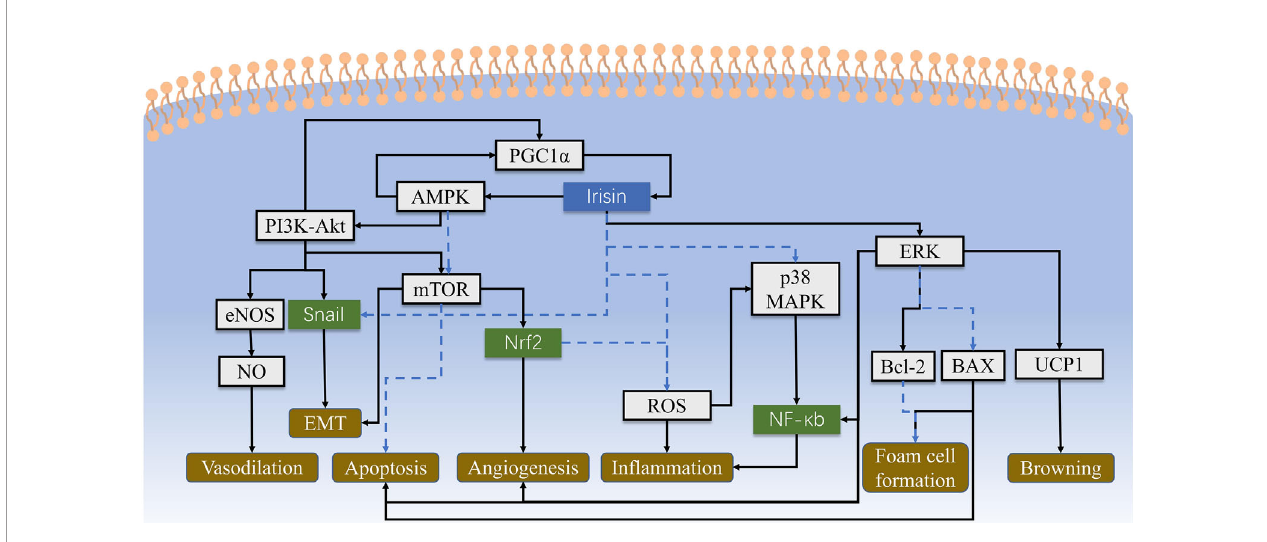
FIGURE 2 | The cell signaling pathways of irisin are intricate and haven ’ t been fully identi fi ed yet. This fi gure shows main cellular biological processes concerning atherosclerosis and CHD, which include AMPK-PI3K-Akt-eNOS, AKT/mTOR, p38 MAPK and ERK pathways to regulate in fl ammation, angiogenesis and other physiological activities. Irisin could also alleviate the damage of ROS directly. Solid lines represent promotion, and dashed lines represent